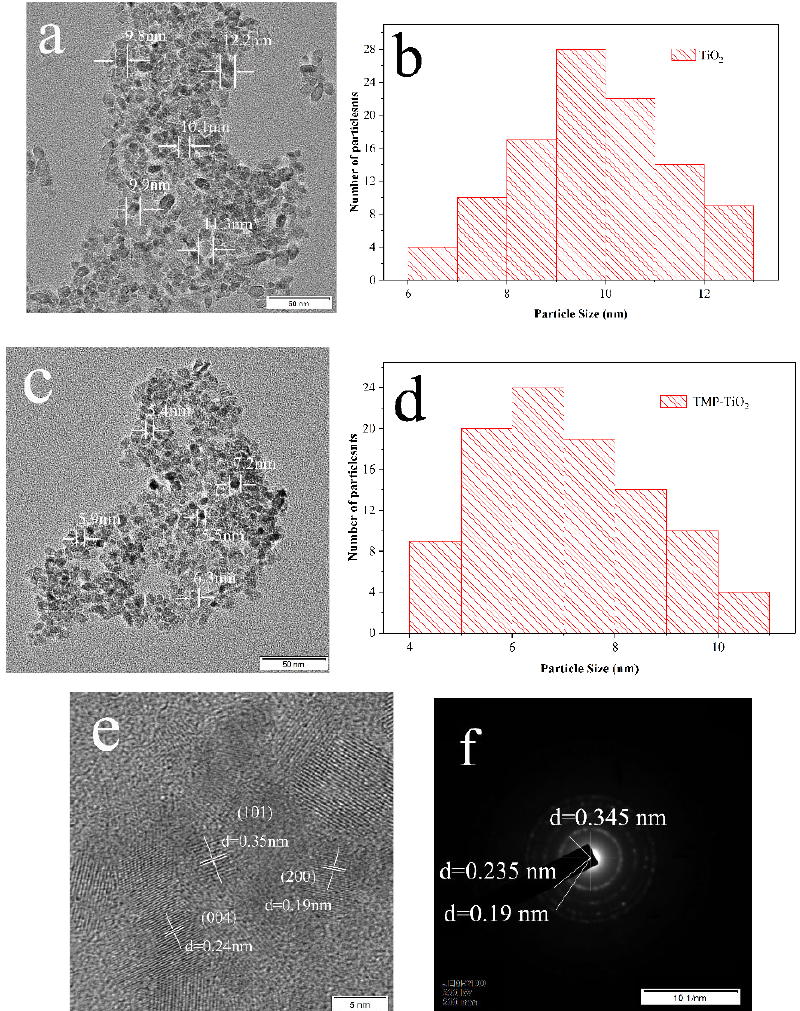
Figure 7. ( a ) Transmission electron microscopy (TEM) images of TiO 2 . ( b ) particle size histogram of TiO 2 , ( c ) TEM images of TMP-TiO 2 , ( d ) particle size histogram of TMP-TiO 2 , ( e ) HR-TEM of TMP-TiO 2 , and ( f ) selected-area electron di ff raction (SAED) pattern of TMP-TiO 2 .